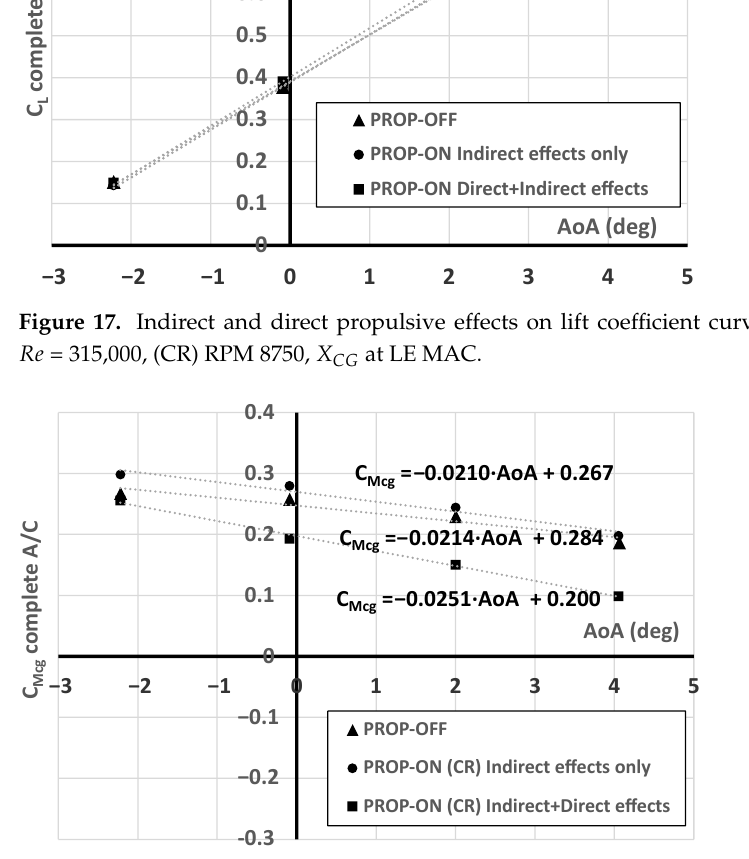
Figure 18. Indirect and direct propulsive effects on pitching coefficient curves versus α , experimental results, Re = 315,000, (CR) RPM 8750, X CG at LE